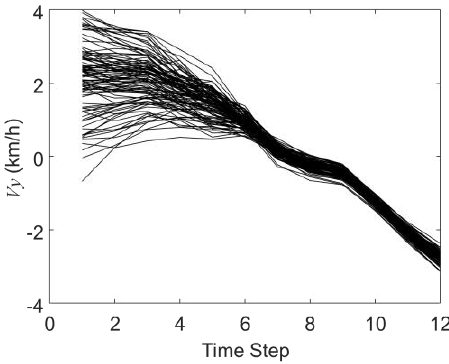
Figure 5. The history matching results of the velocity in the X-direction ( V x ).